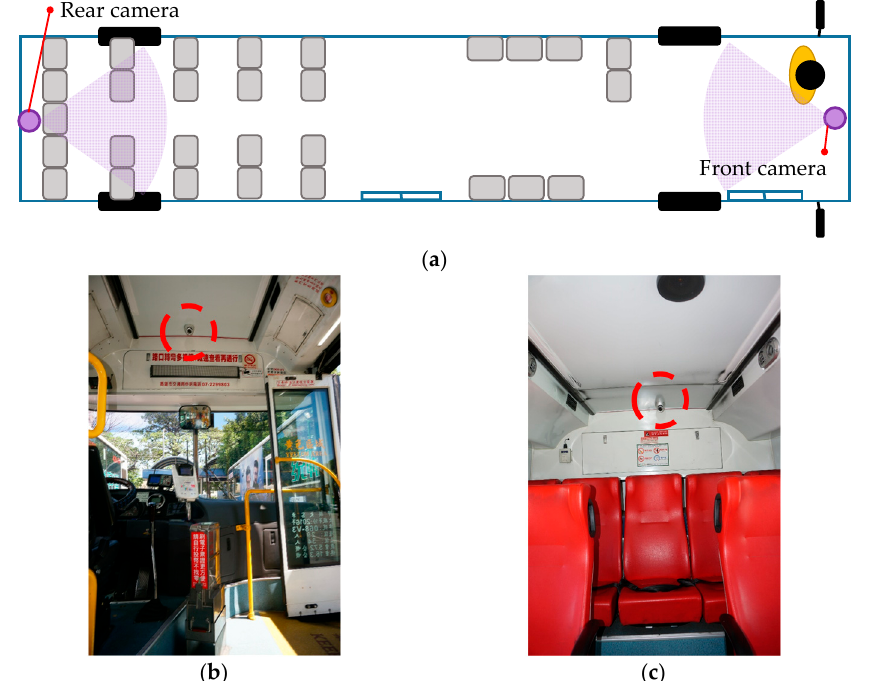
Figure 2. Positions of the surveillance cameras: ( a ) internal configuration of the bus—images of ( b ) front camera and ( c ) rear camera.